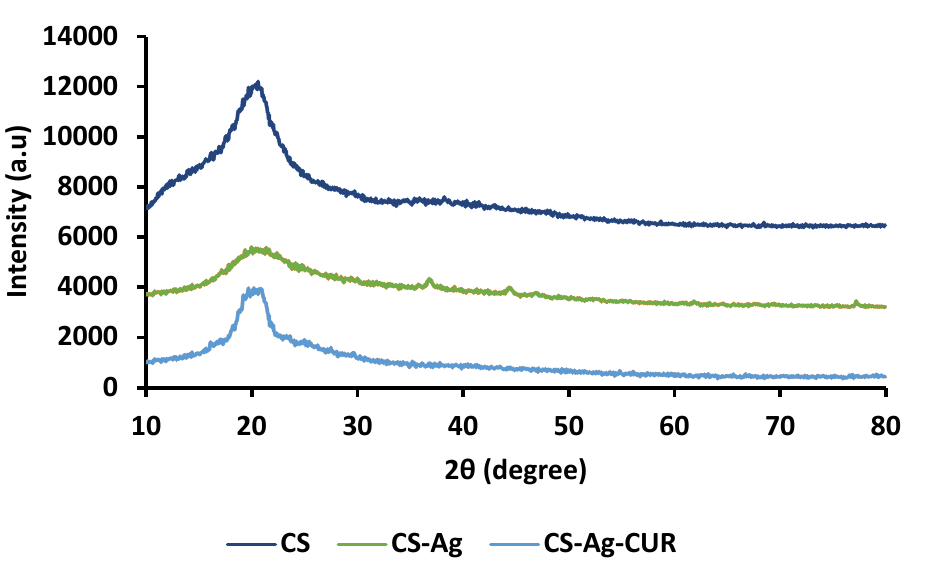
Figure 4. The XRD patterns of CS, CS-Ag, and CS-Ag-CUR.